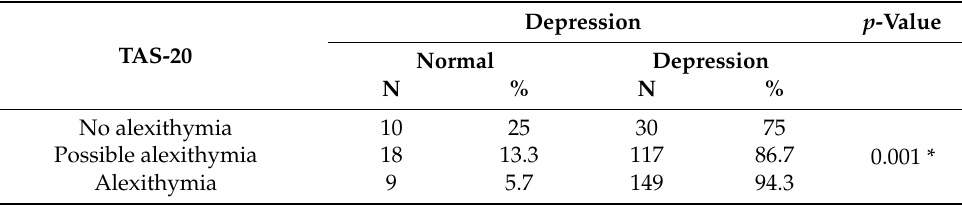
Table 2. Relationship between alexithymia and depression among medical students at King Khalid University, Saudi Arabia, 2022. TAS-20